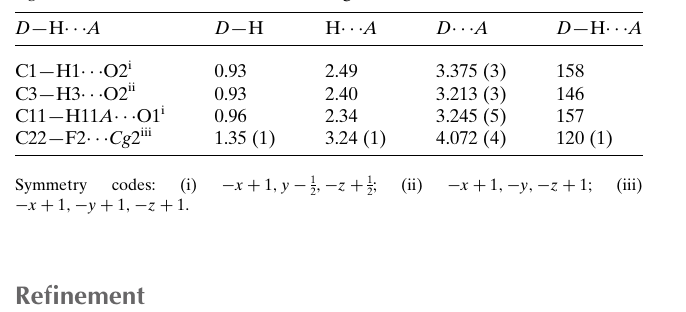
Table 1 Hydrogen-bond geometry (A˚ , (cid:4) ). Cg 2 is the centroid of the C1–C5/N2 ring.